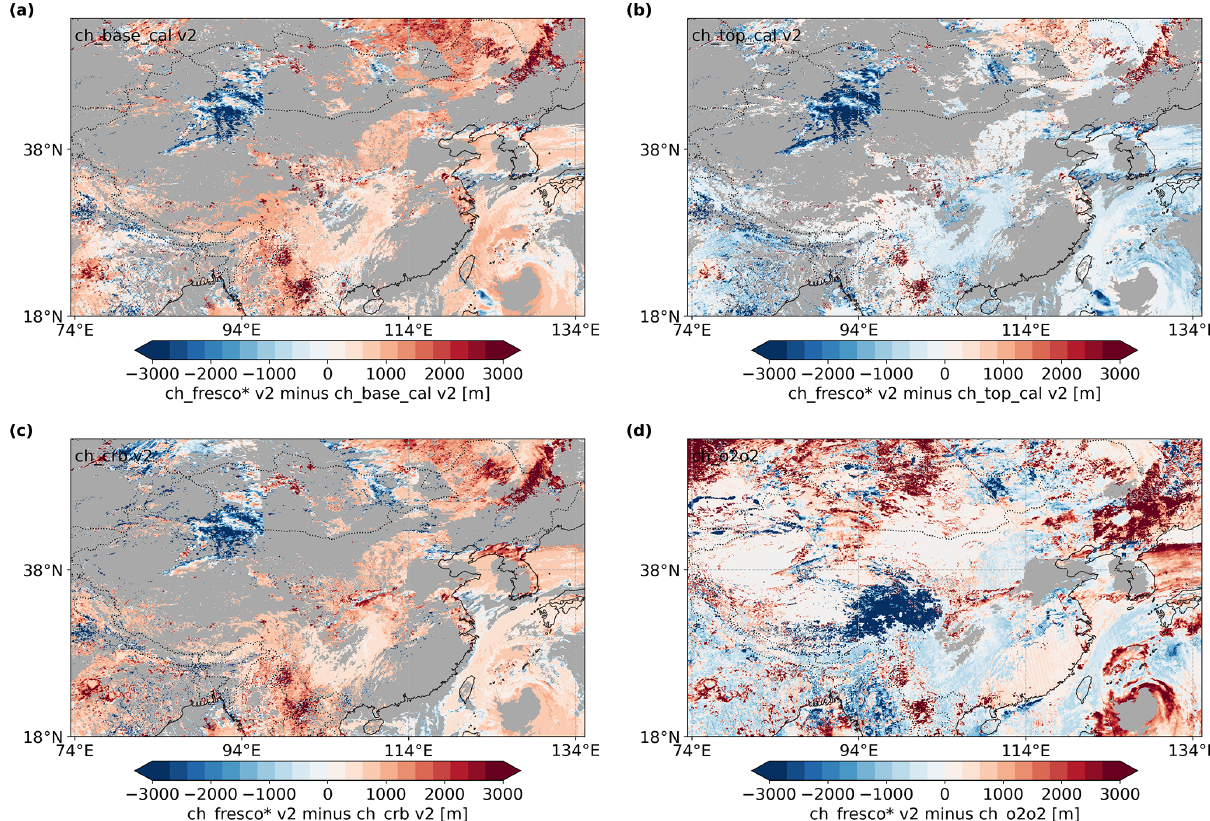
Figure 13. Differences between the version 2 (a) ROCINN CAL CBH, (b) ROCINN CAL CTH, (c) ROCINN CRB CH, and (d) O 2 –O 2 CH and the FRESCO CH from the TROPOMI NO 2 product (ch_fresco*) for China and the autumn day (20 September